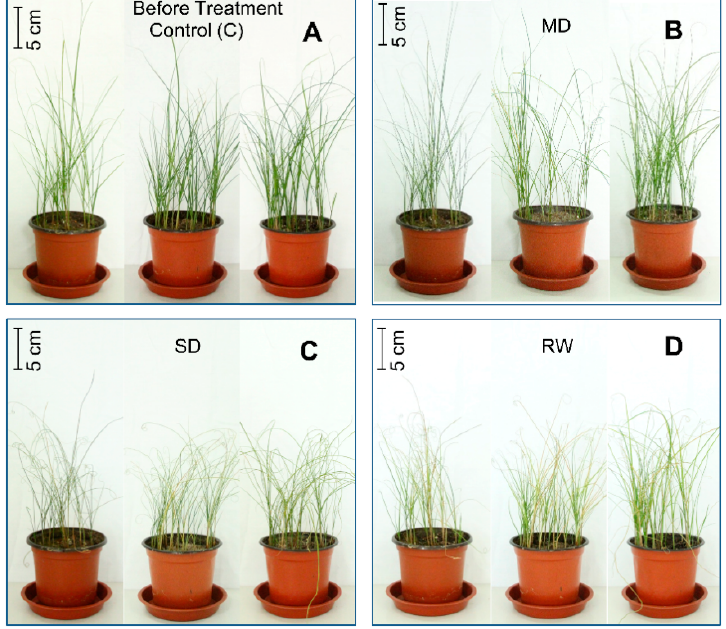
Figure 1. Phenotype of C. duriuscula before and after 14 d of drought treatment and after re-watering. ( A ) Control (C): the soil field capacity (FC) was maintained at 75–80%. ( B ) Mild drought (MD), with FC = 40–45%. ( C ) Severe drought (SD) with FC = 20–25%. ( D ) Re-watering (RW); FC = 75–80%.